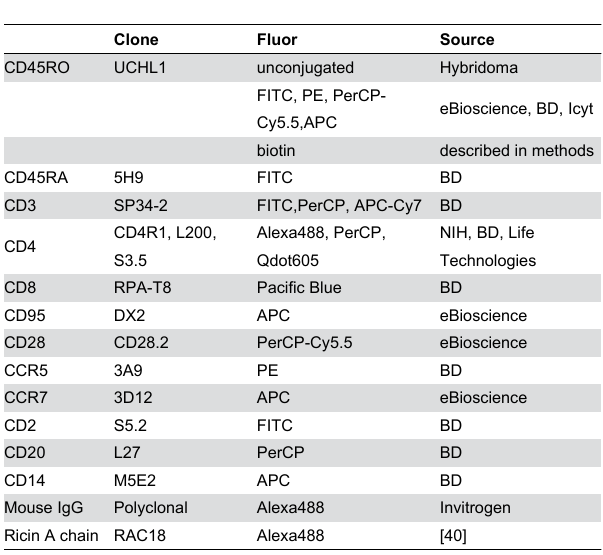
Table 1. Antibodies used in these